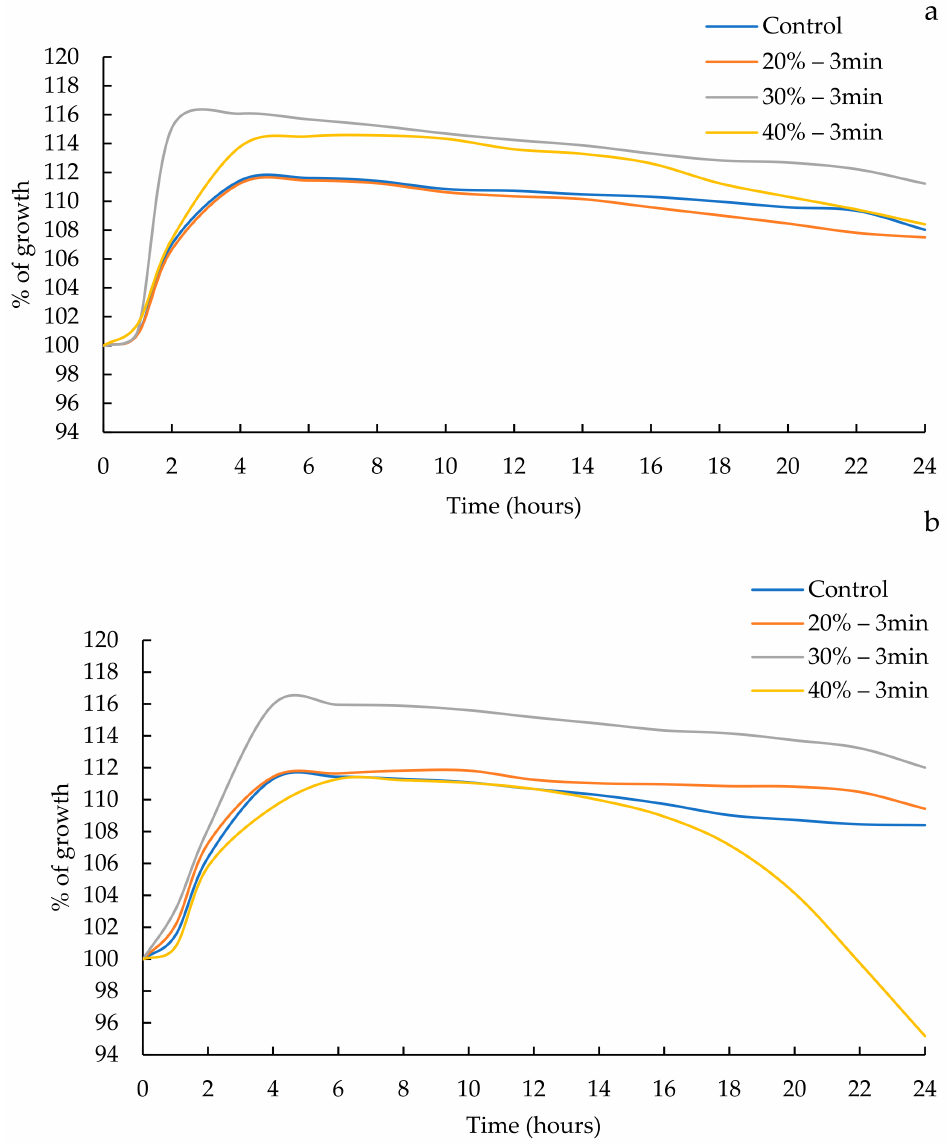
Figure 2. Effect of ultrasound (20 kHz) on the growth percentage of L. acidophilus ( a ) and L. helveticus ( b ) at 37 ± 1 ◦